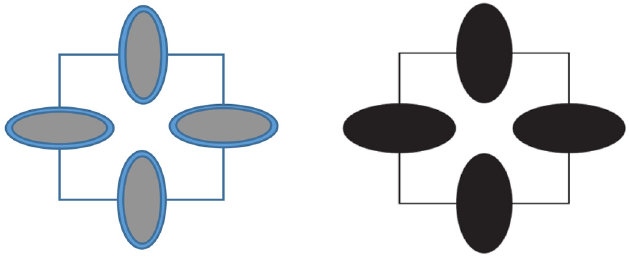
Fig. 3. Unit cell with square ellipse inclusion (left), equivalent inclusion (right).